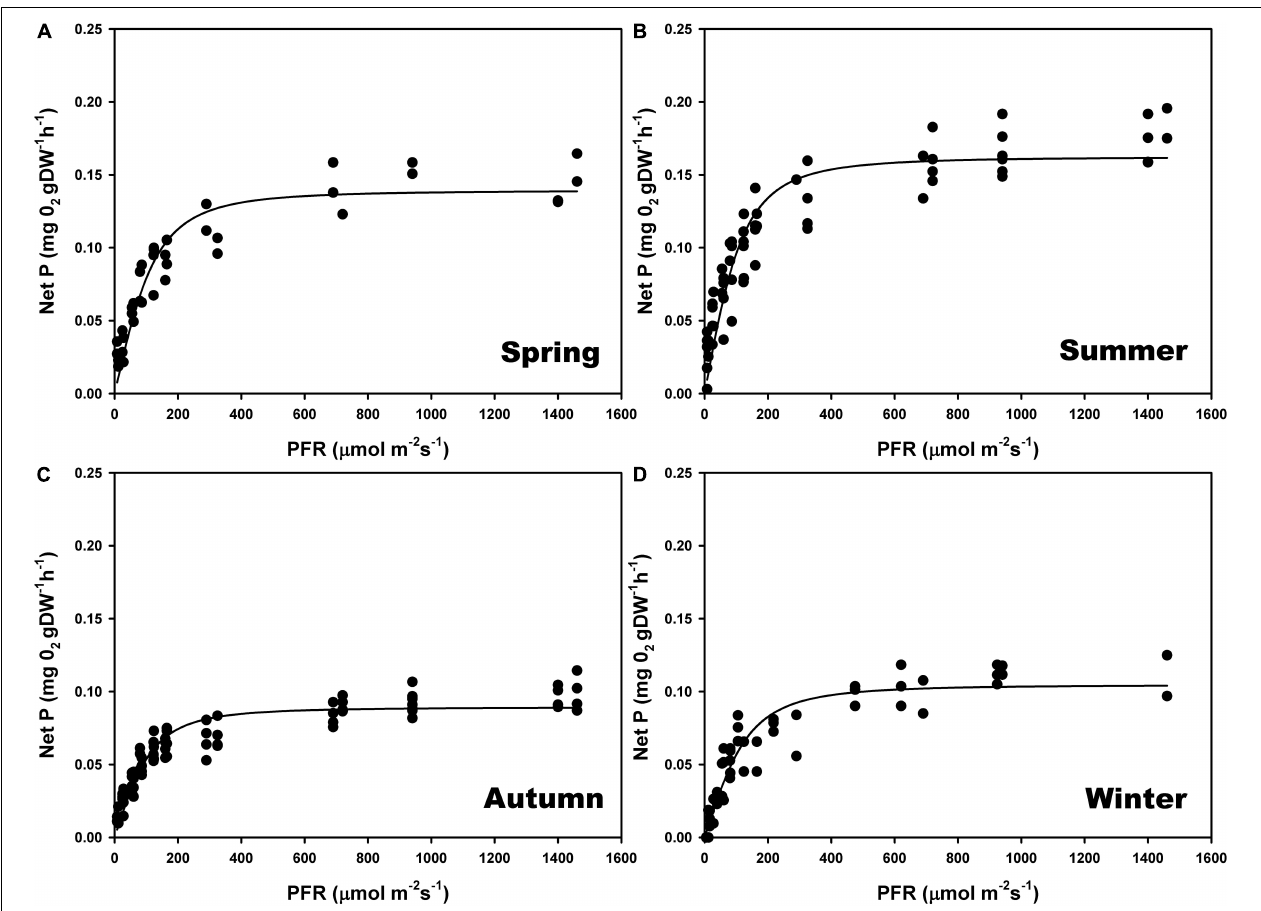
FIGURE 4 | Seasonal photosynthesis–irradiance (P–E) curves, determined on individual thalli of P. lusitanicum in the laboratory using an oxygen Clark-type electrode ( n = 5) during spring (A) , summer (B) , autumn (C) , and winter (D) . Curves represent the adjustment of the model equation of Smith (1936) and Talling (1957) to the observed values.